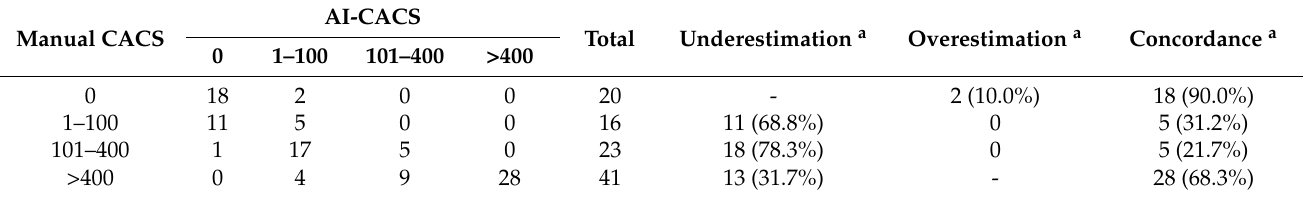
Table 3. Confusion matrices of risk categories between AI-CACS and manual CACS. Weighted Kappa values were 0.8.